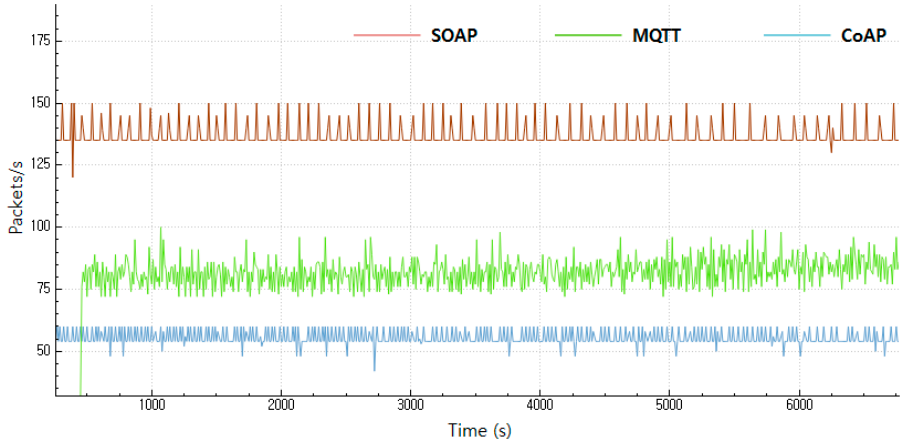
Figure 9. Protocol I/O Graph.